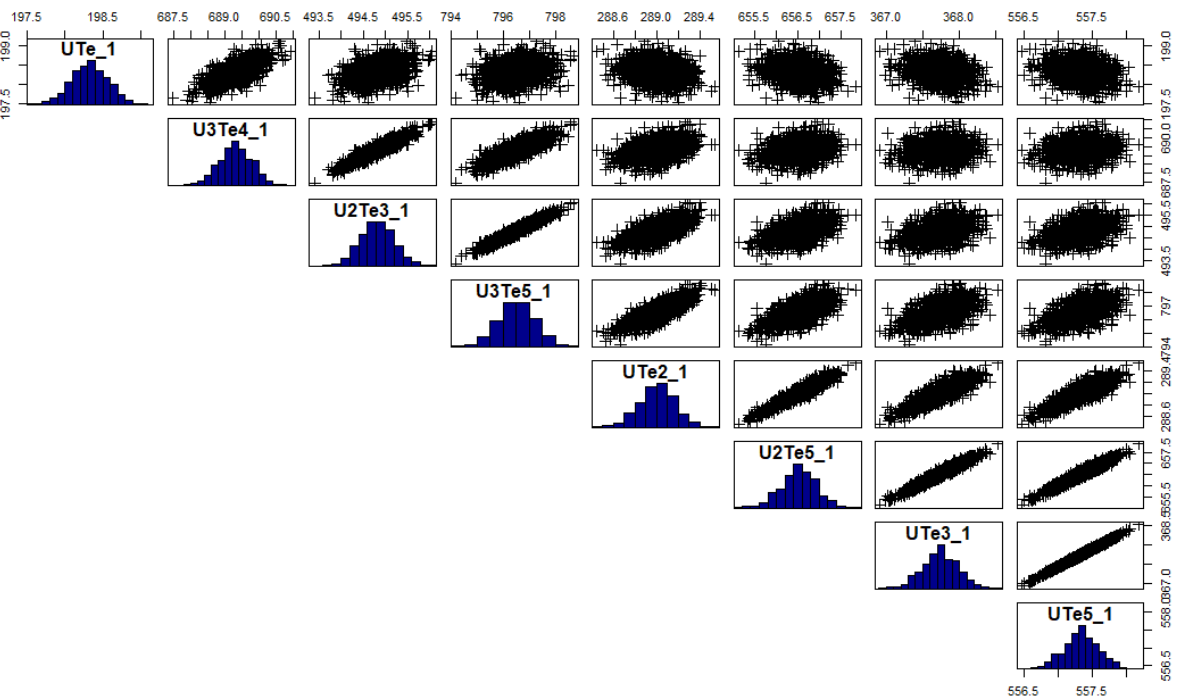
Figure 8. Parameter posterior probability distributions and correlations matrix plot for the compounds entropic parameters. The posterior correlation values can be found in Appendix B.